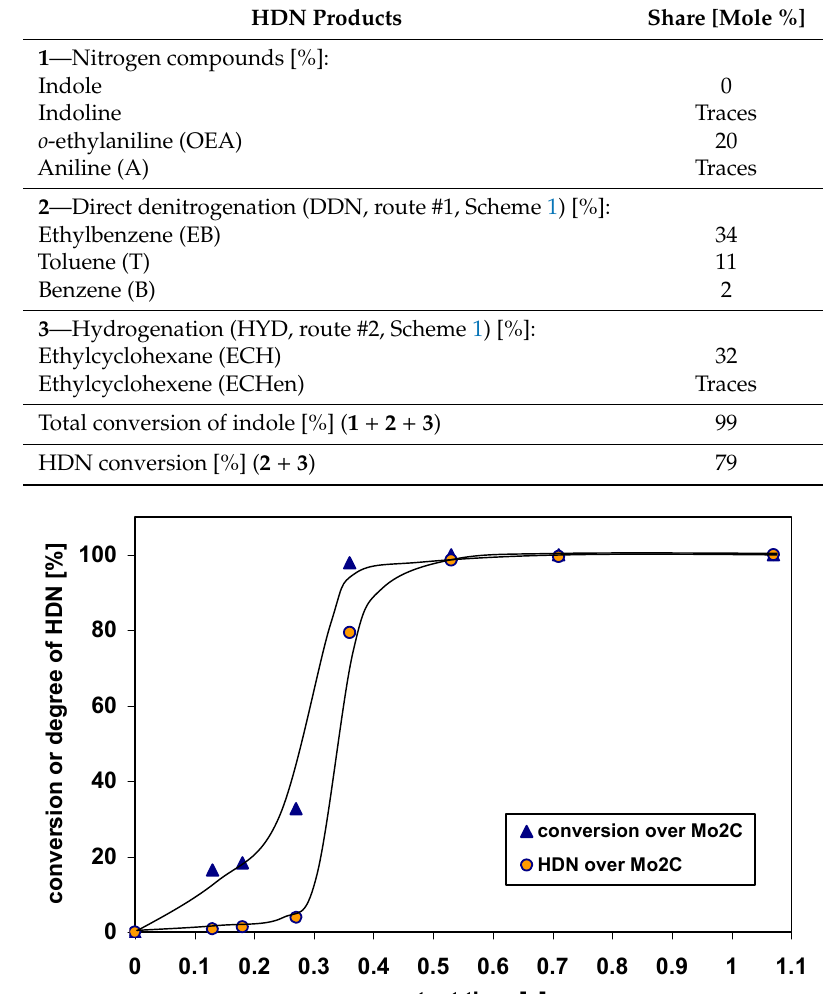
Table 1. Distribution of products (mole %) during the indole HDN over Mo 2 C catalyst at 613 K, 6 MPa, H 2 / feed = 600, and at a contact time of 0.37 s.